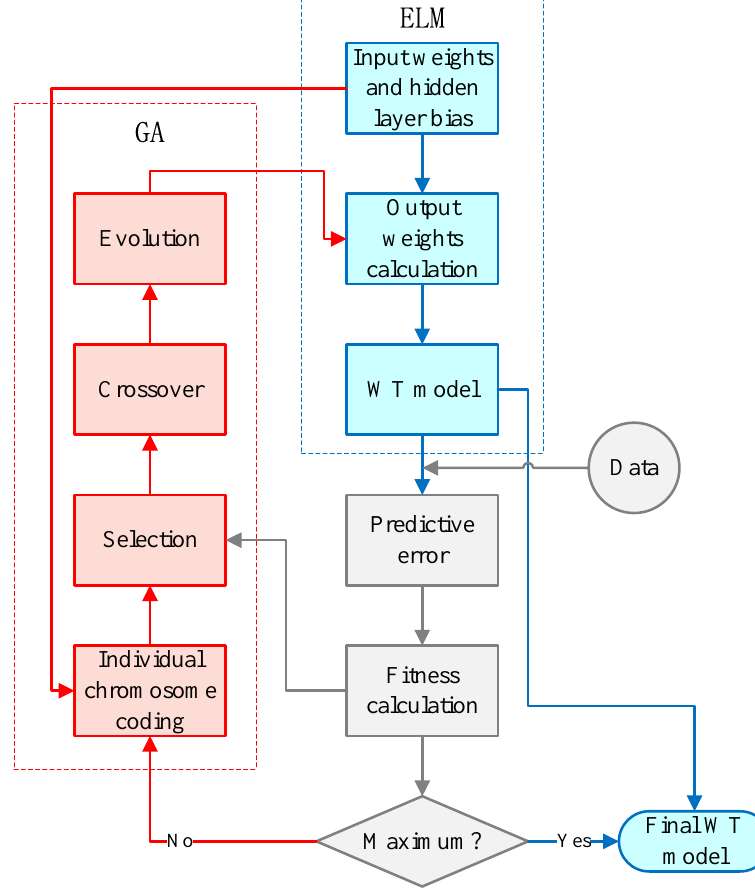
Figure 6. Topology of Extreme Learning Machine (ELM).